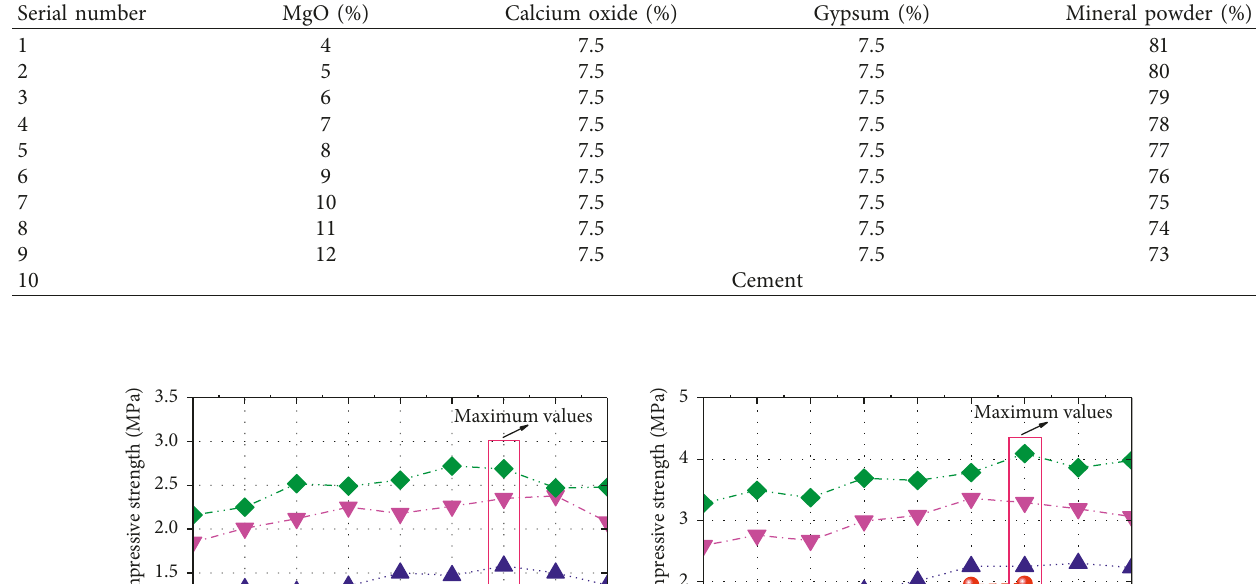
Table 6: Proportions of solidifying materials.